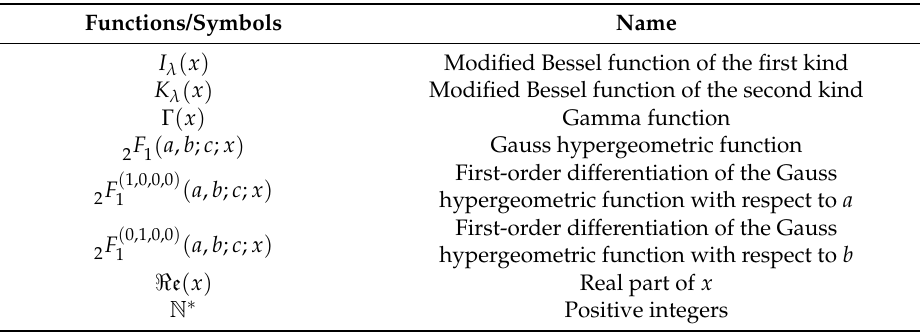
Table 1. Special functions and mathematical